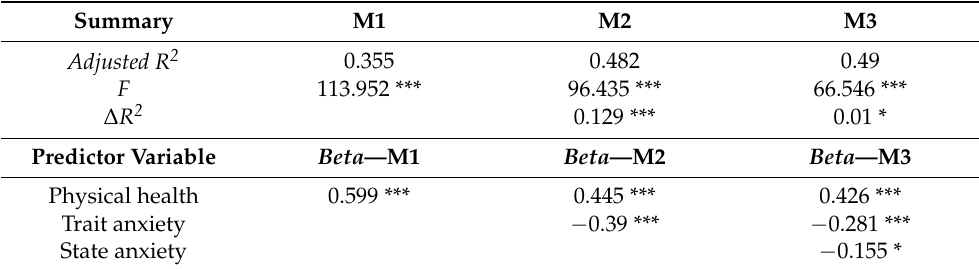
Table 9. Regression analysis of mental health in prison.